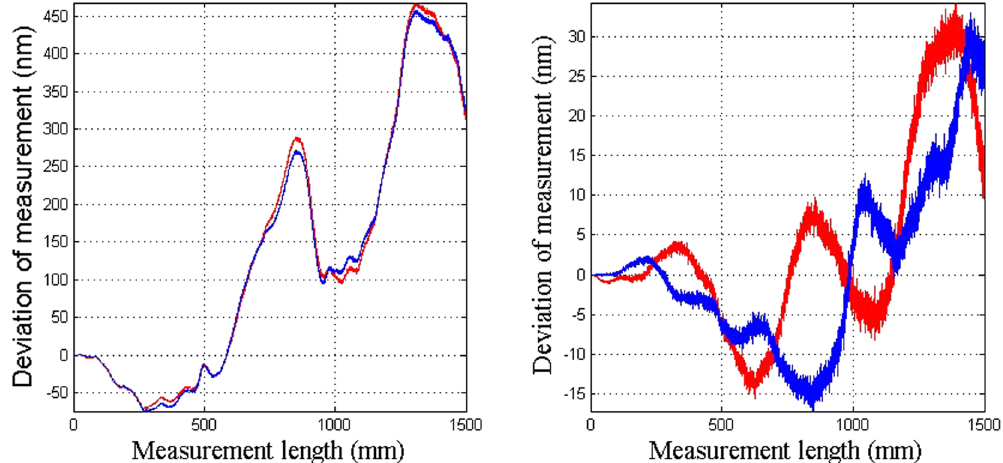
Figure 4. The accuracy of the one-color method: ( a ) the deviation using the one-color method; ( b ) the uncertainties in the optical distance.